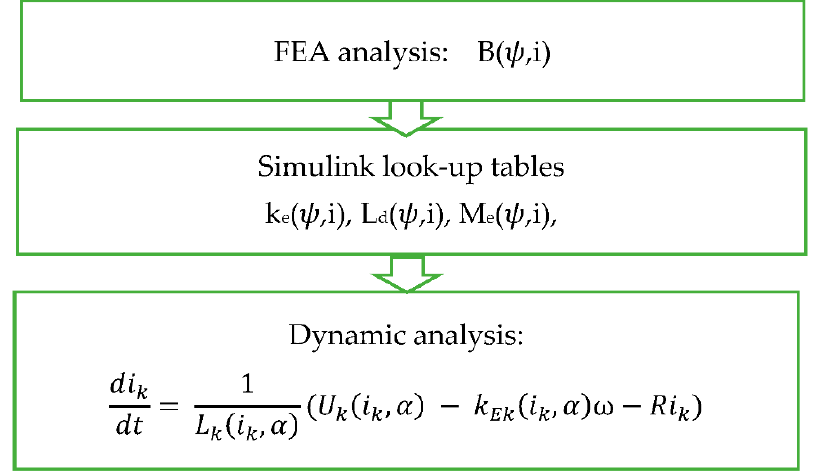
Figure 10. Scheme of SRM Modelling.